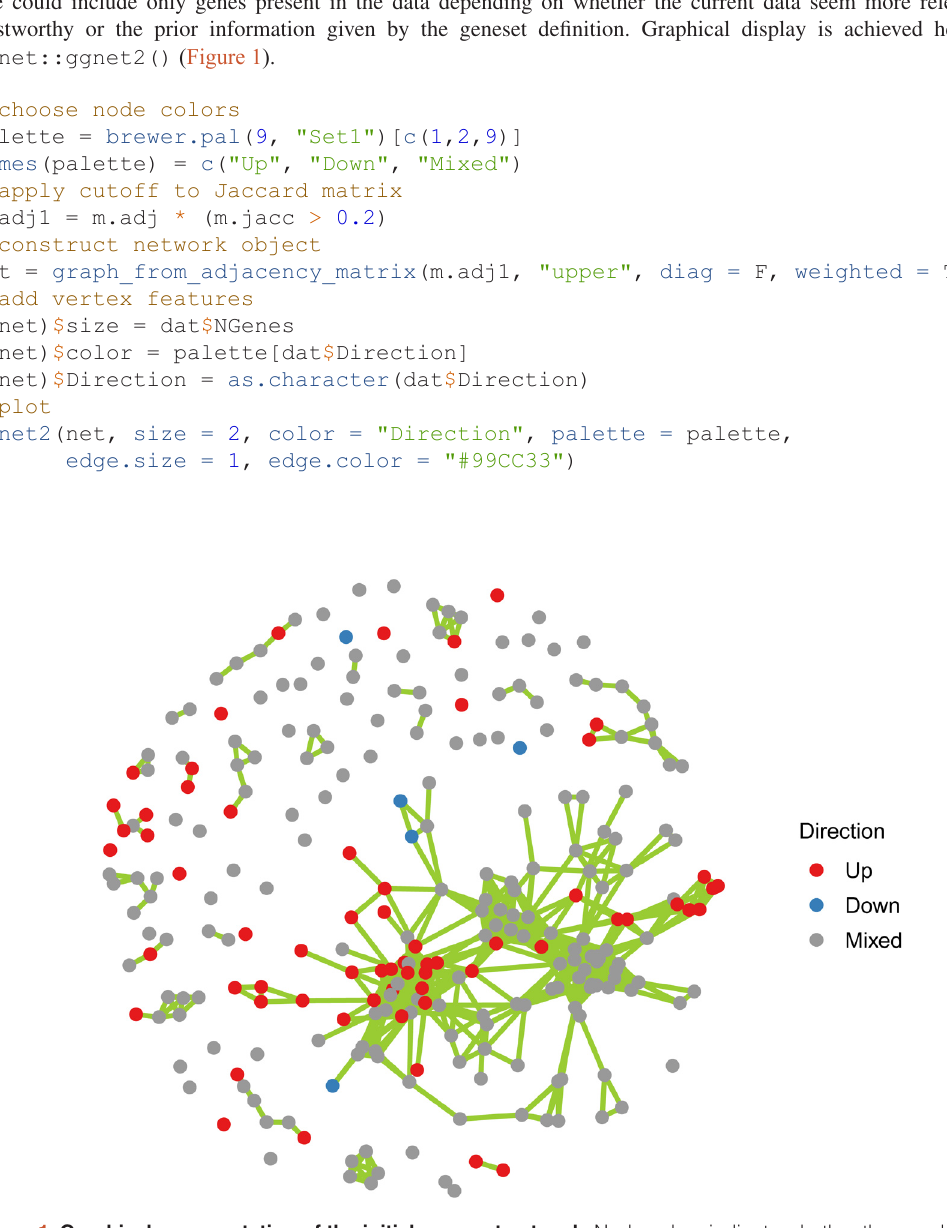
Figure 1. Graphical representation of the initial gene set network. Node colors indicate whether the member genes of a set are predominantly up or down regulated or whether there is no preferential direction